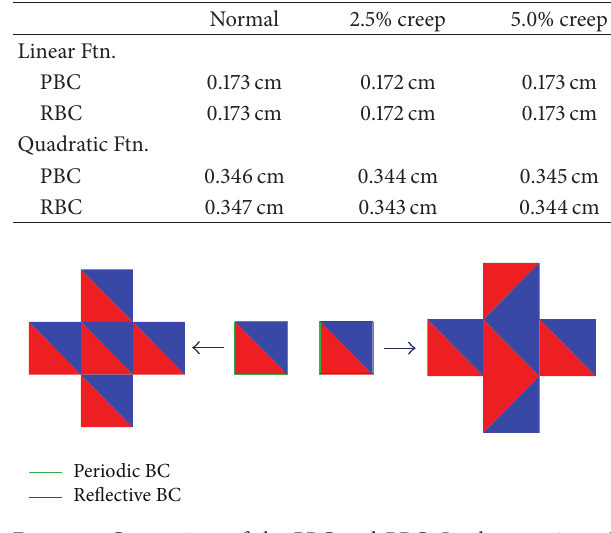
Figure 1: Comparison of the PBC and RBC. Implementation of the periodic boundary condition: (i) difference of periodic BC and reflective BC and (ii) physical interpretation. (a) Because the same structure is repeated for the periodic BC, the flux values of the same position on the every line on the periodic BC are the same. (b) Because the GMSH gives the same coordinates for the nodes on the periodic boundary condition, the implementation of the periodic BC is much